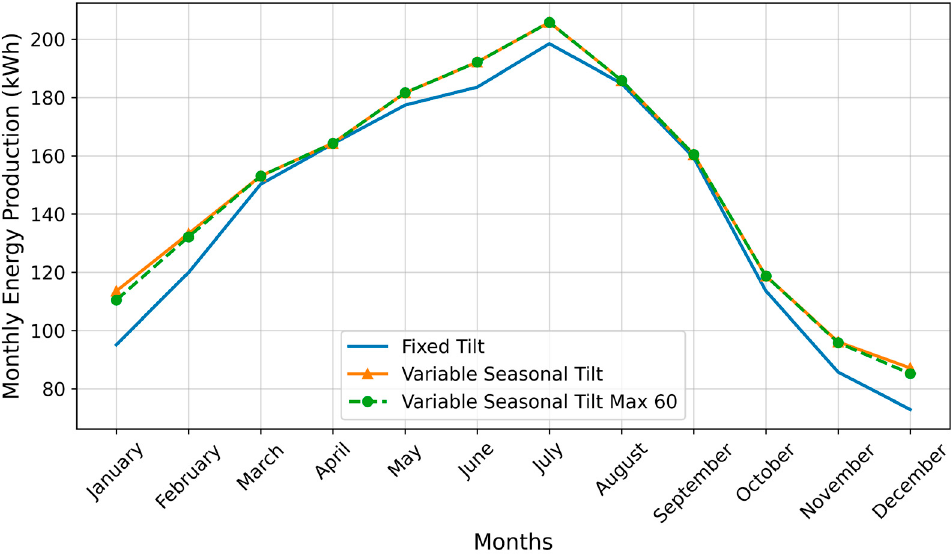
Figure 10. Monthly energy production during year 1 of the simulations’ three scenarios.